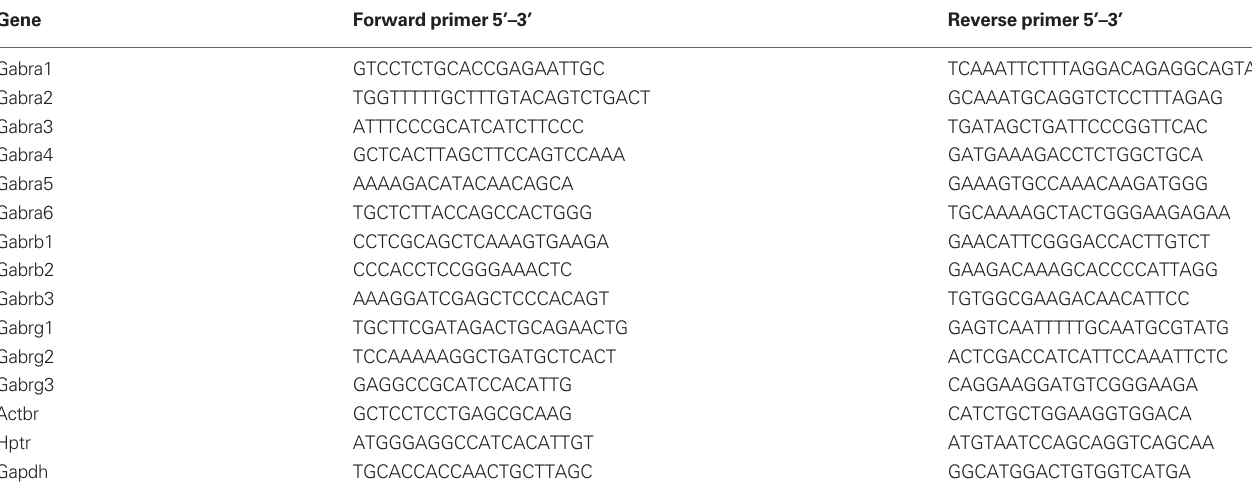
-receptor subunits and housekeeping genes used for real-time A